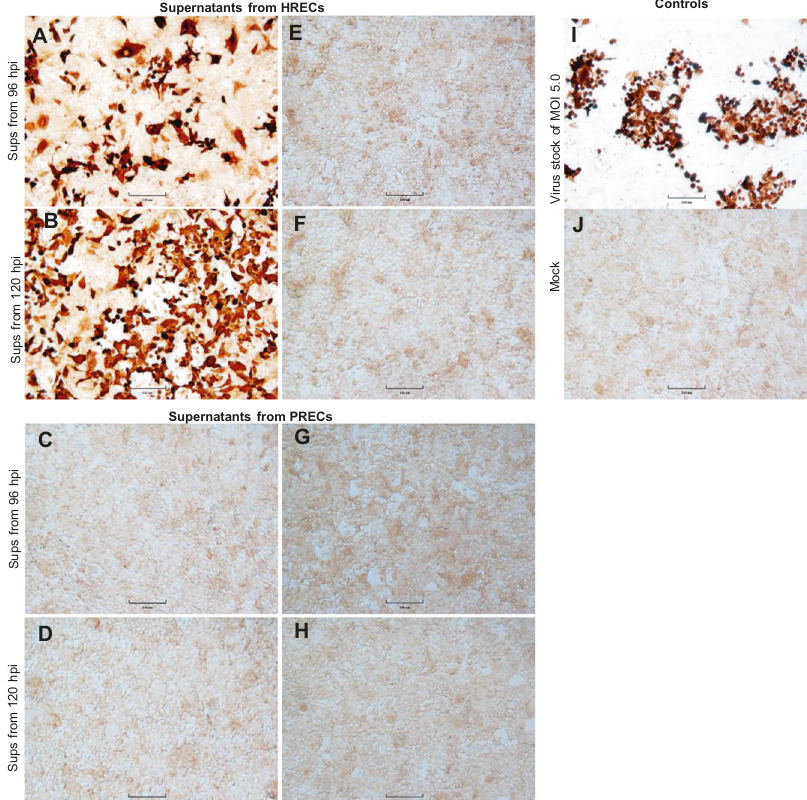
Fig. 6 Supernatants collected from PRECs previously inoculated with a SARS-CoV-2 were not infectious. Immunocytochemistry images of 4% paraformaldehyde- fi xed Vero-E6 cells showing the expression of SARS-CoV-2 N protein. Cells stained with ImmPRESS VR anti-rabbit IgG horseradish peroxidase (HRP) polymer detection kit (MP-6401-15) and a recombinant anti-SARS-CoV-2 N protein rabbit monoclonal antibody (0.75 μ g/mL) (the following reagent was obtained through BEI Resources; NR-53791). Dark brown spots represent a positive expression, and pale brown spots represent background staining. Scale bar — 100 μ m. A – J Vero-E6 cells inoculated with supernatants from A , B HRECs and C , D PRECs previously infected with SARS-CoV-2 (MOI 5.0) and their corresponding supernatants from E , F HRECs and G , H PRECs mock-inoculated with culture medium (negative controls). The A , E , C , and G panels correspond to supernatants collected at 96 hpi, while B , F , D , and H panels correspond to supernatant collected at 120 hpi. I Vero-E6 cells inoculated with SARS-CoV at MOI 5.0, from the original SARS-CoV-2 virus stock, used as IHC positive control, and J corresponding mock-inoculated